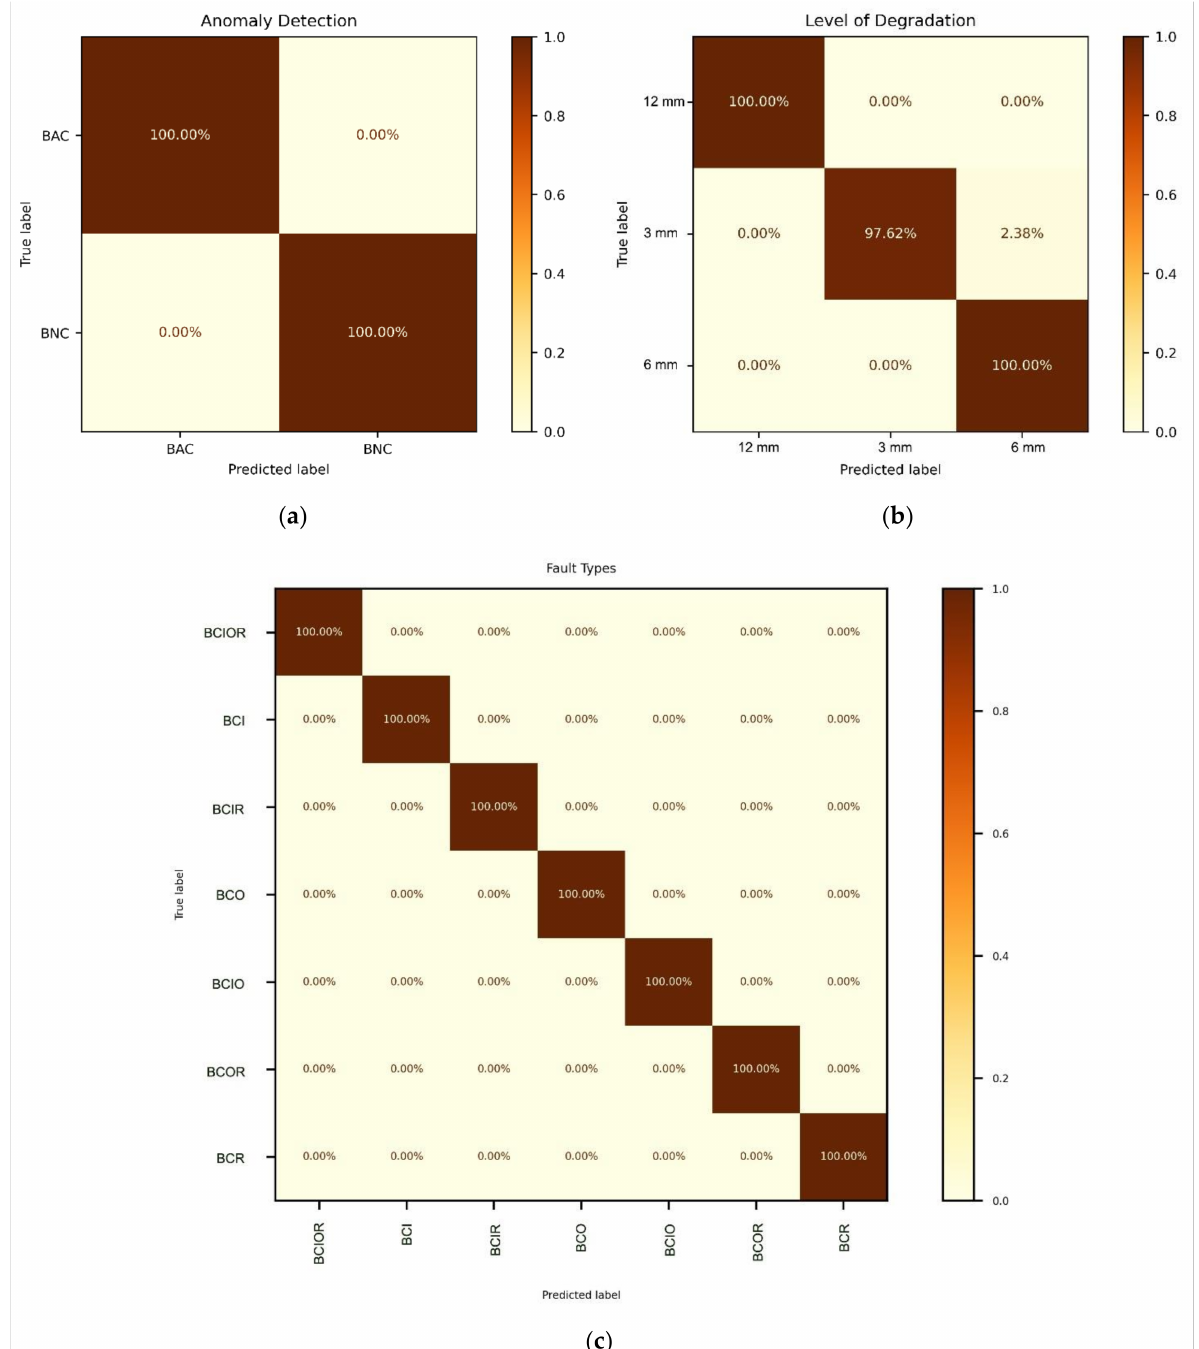
Figure 4. Confusion matrix showing the classification results for separate diagnosis tasks: ( a ) anomaly detection, ( b ) level of degradation classification, ( c ) compound fault type